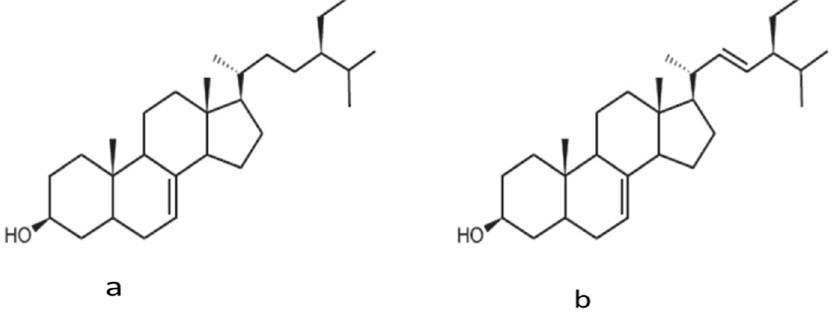
Figure 2. Schottenol ( a ) and spinasterol ( b ) structure presented in prickly pear seed oil. Sourced from El Kharrassi et al. [42].